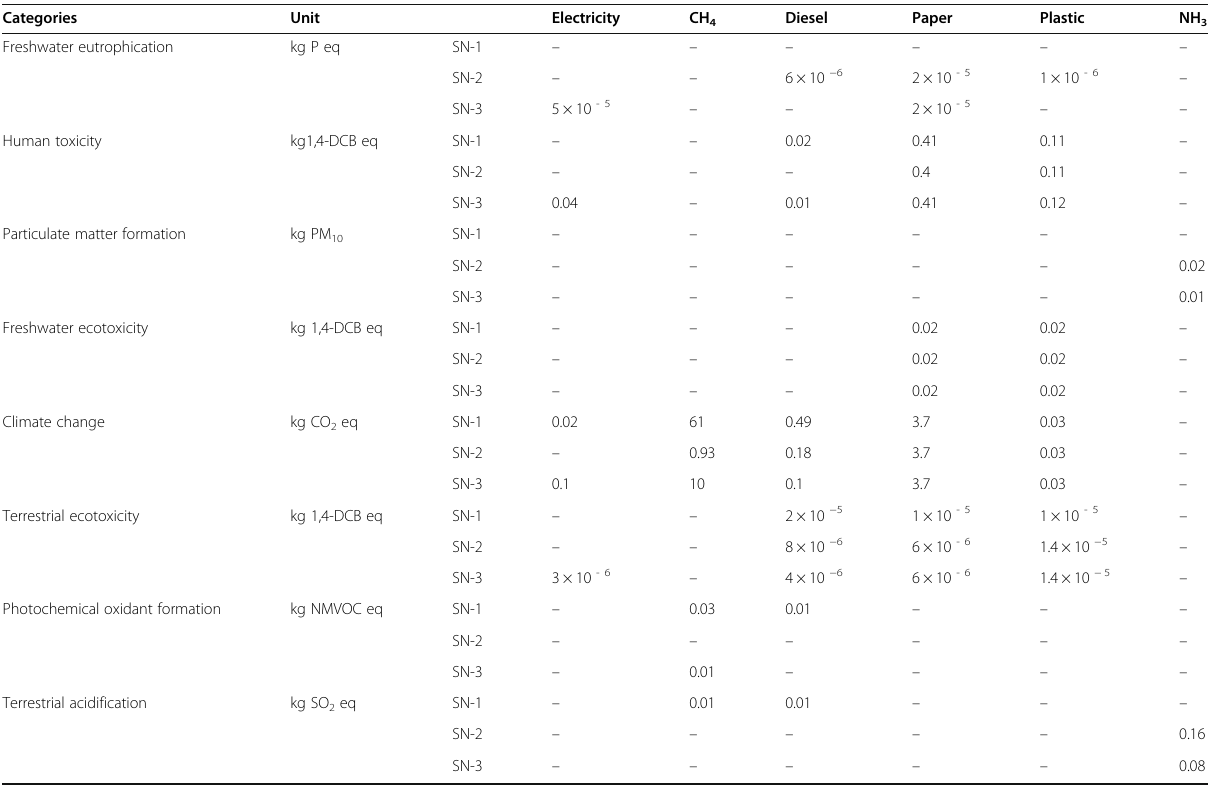
Table 9 Sensitivity analysis on 5% improvement of process and resources recoveries